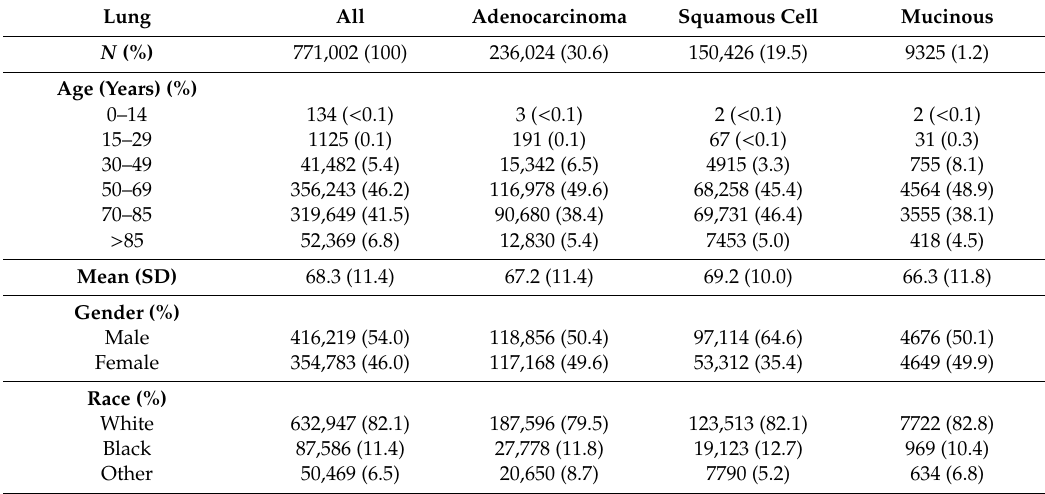
Table 5. Baseline demographics and clinical characteristics by histology for lung